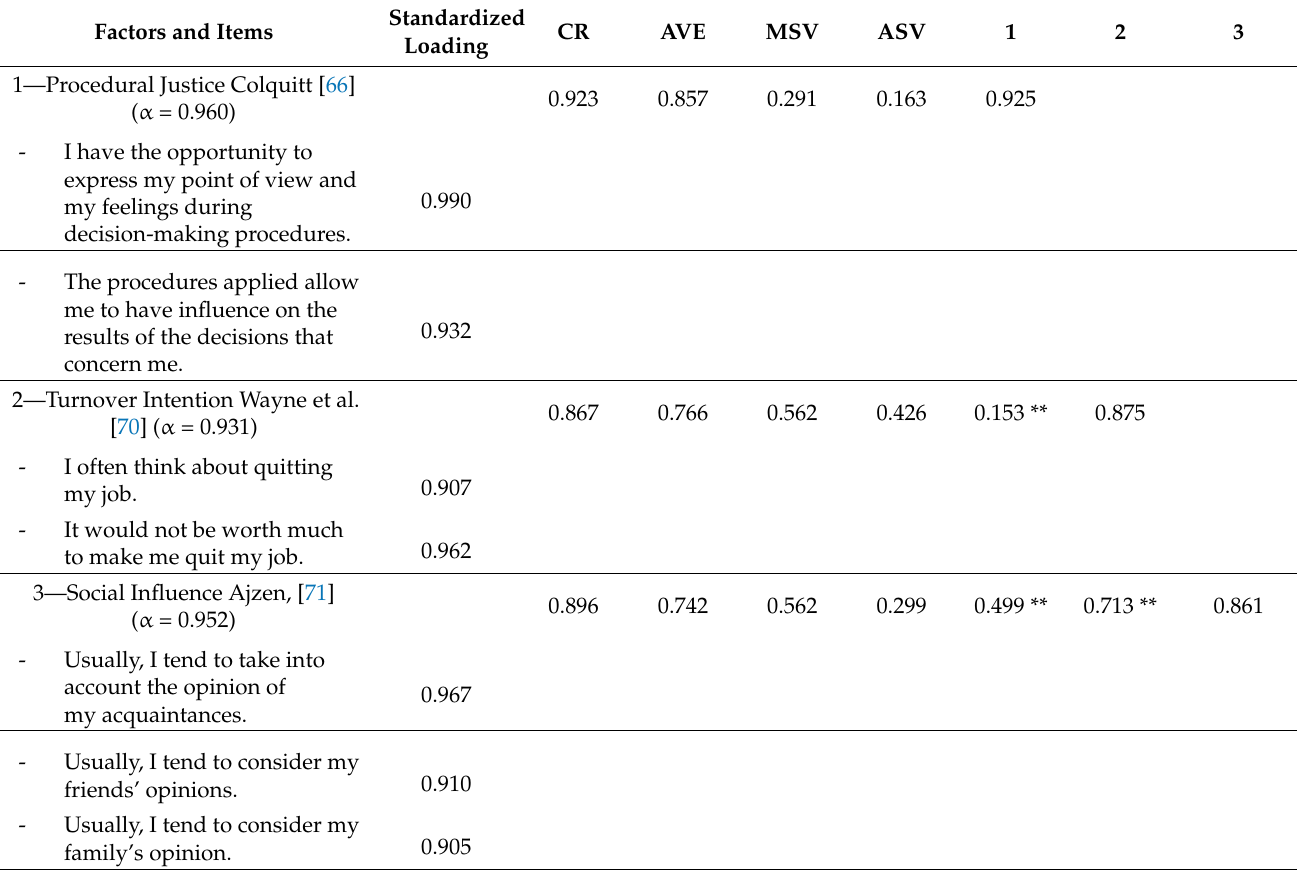
Table 2. Convergent and discriminant validity (developed by